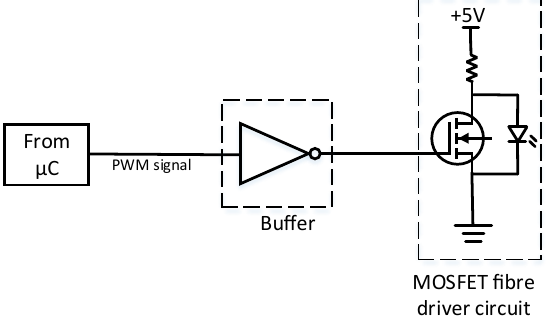
Figure 3. Optical fibre driver